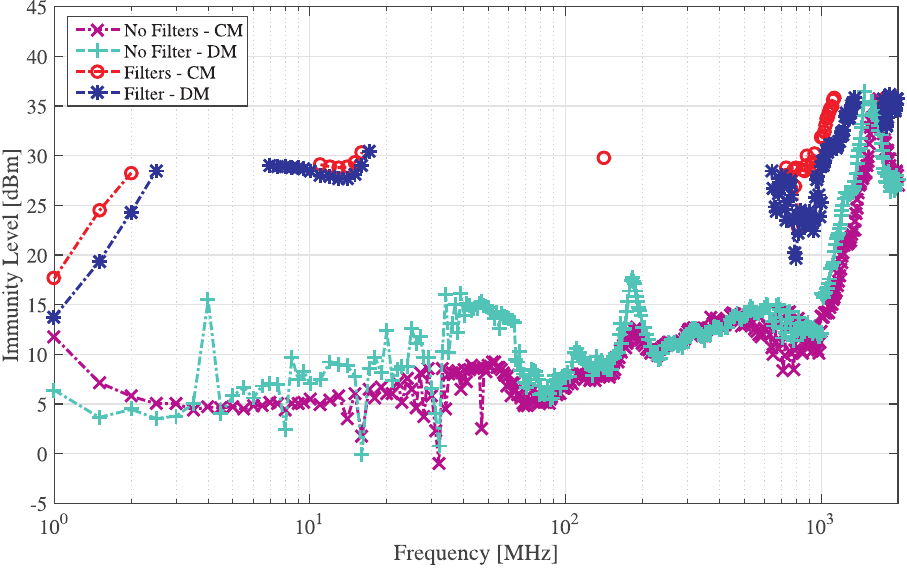
Figure 4. Measured immunity level (expressed in terms of RF incident power) for DPI on the cell input pins: differential (DM) and common-mode (CM) injection, with and without RC 100 Ω , 100 nF RC filters in Figure